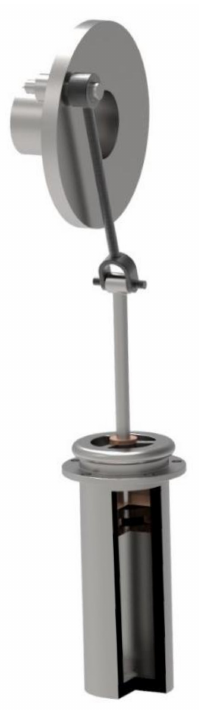
Figure 21. Juice pump subassembly.